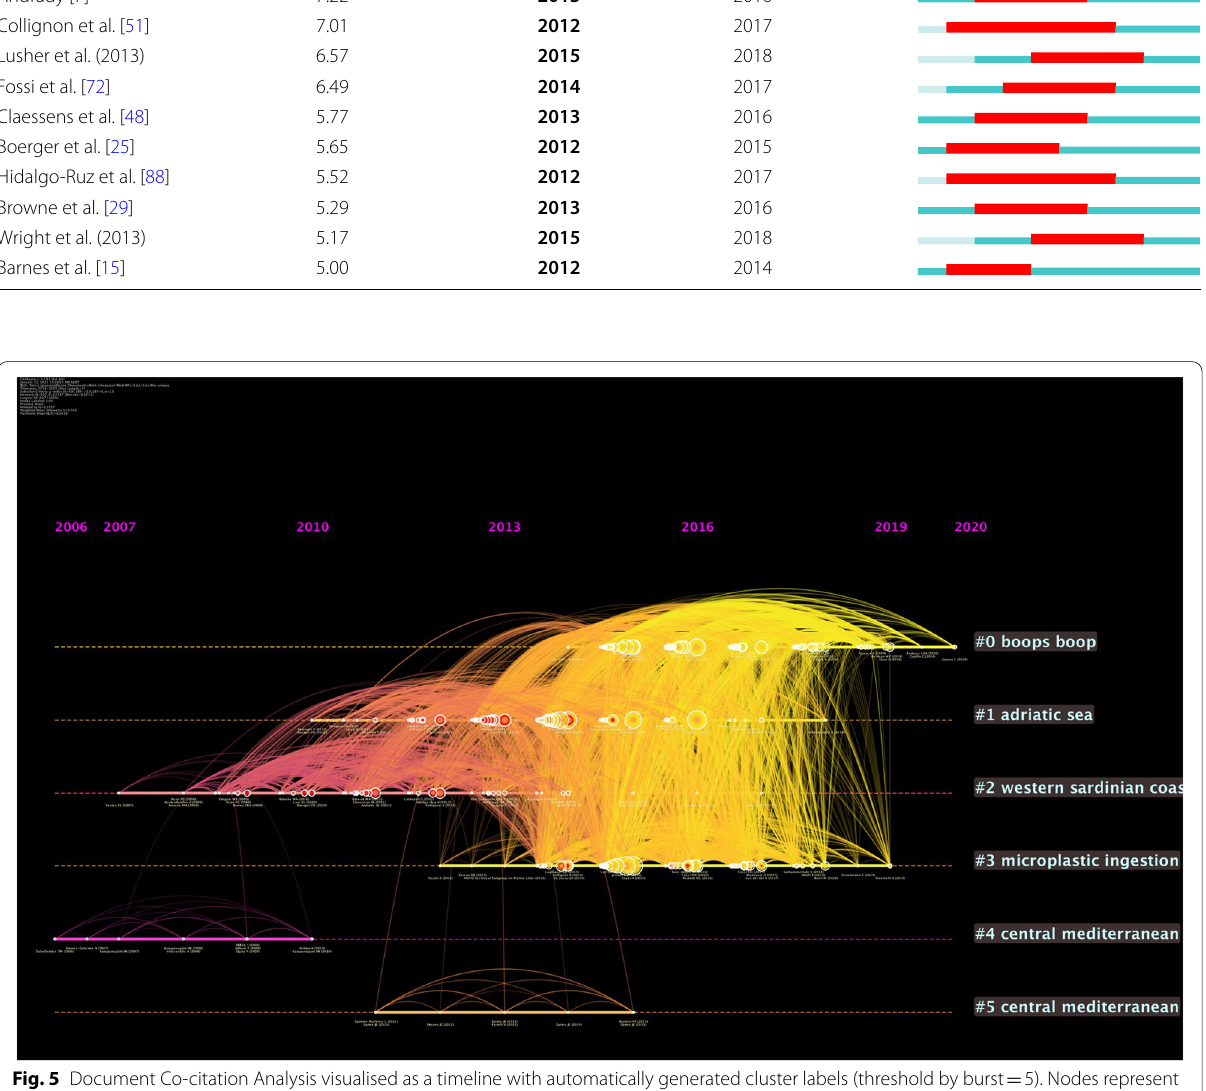
Fig. 5 Document Co-citation Analysis visualised as a timeline with automatically generated cluster labels (threshold by burst cited documents labelled with first author and year of publication. Nodes below the threshold were not labelled. The colour of co-citation links is indicative of the transition of research focus over time, with the most recently established links in yellow. Modularity Q silhouette =